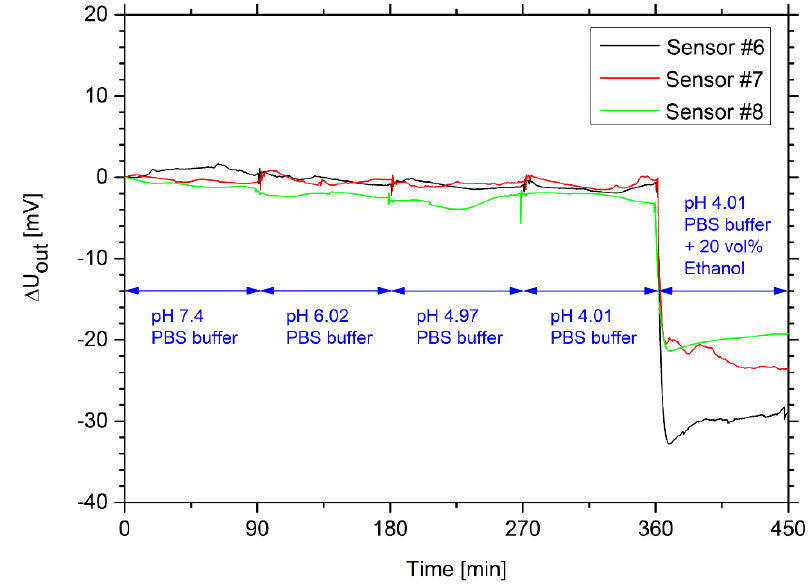
Figure 6. Time-dependent change of the output voltage for three hydrogel-based sensors in ethanol-free PBS solution with different pH values in a range from pH 7.4 to 4.01. To underline the ethanol sensitivity of the sensors, a 20 vol% ethanol solution with PBS buffer, pH 4.01, was measured at the end of the experiment.